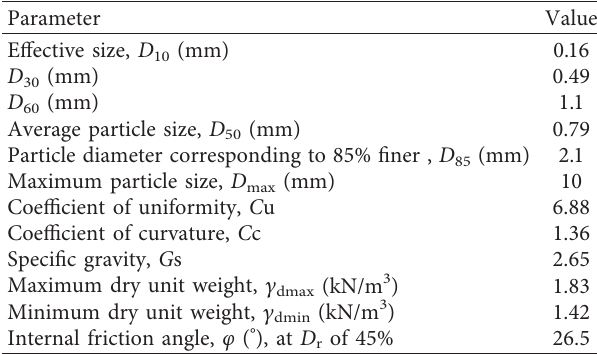
Figure 3: Particle size distribution curve of the coarse sand. Table 2: Physical properties of coarse sand used in the study.